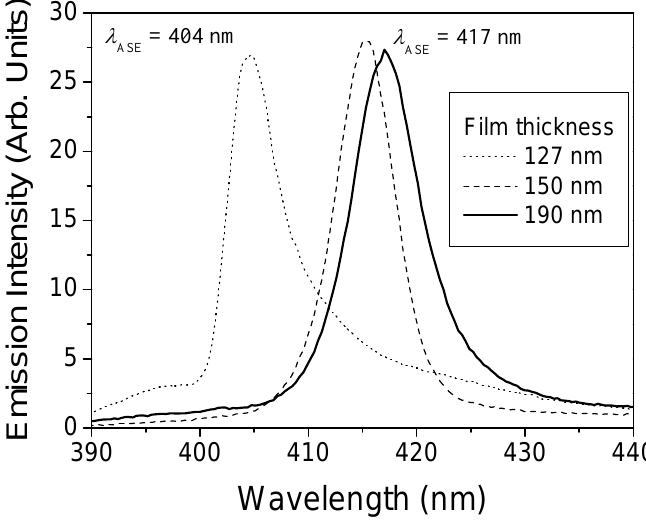
Figure 7. ASE spectra for 15 wt% TPD-doped PS films of various